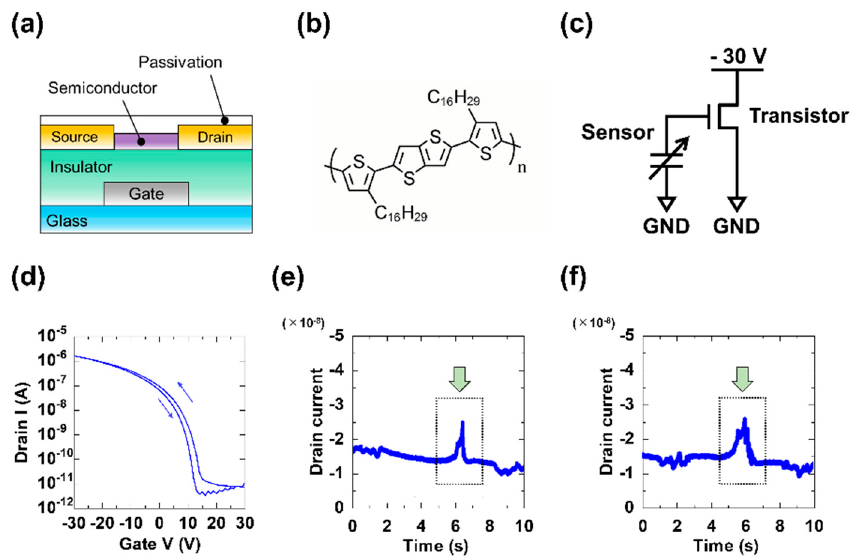
Figure 5. An organic thin-film transistor (OTFT) device: ( a ) Fabricated OTFT device; ( b ) Chemical structure of the molecule intended as the organic semiconductor; ( c ) Amplifier circuit diagram; ( d ) Transfer characteristics of the OTFT; Piezoelectric responses of the OTFT device under ( e ) 1 kPa and ( f ) 10 kPa of applied